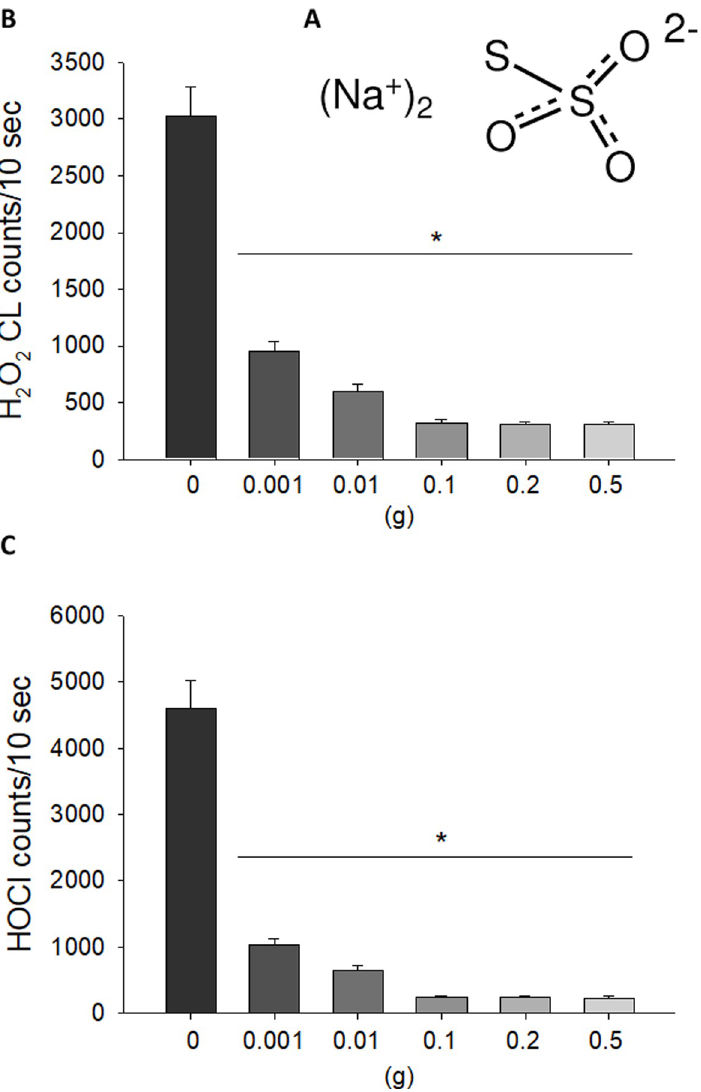
Fig 1. The structure (A) and effect of STS on H 2 O 2 (B) and HOCl (C) scavenging activity. Data shows that STS displays a dose-dependent manner in scavenging H 2 O 2 and HOCl activity and a maximal effect is at the dosage of 0.1 g. � P < 0.05 vs. saline control (0). Data are expressed as mean ± SEM (n =